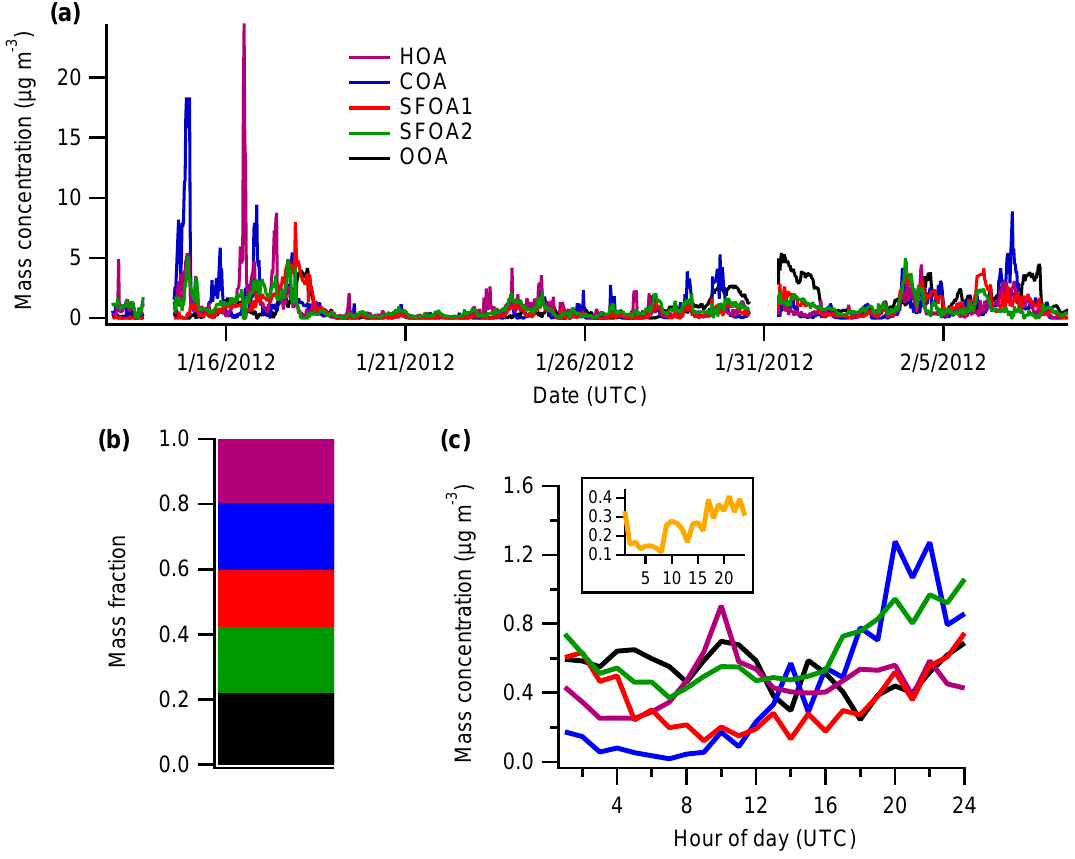
Figure 1. (a) Time series of the 5-factor-PMF solution from the HR-ToF-AMS. (b) Average fractional contribution to the total non-refractory submicron organic aerosol mass, where the residual accounts for 1.24% of the mass (also see Fig. S27 in Sect. 5.1.2 in the Supplement to Young et al. (2014), the complementary paper). (c) Median diurnal profiles for each of the five factors and the diurnal profile of the difference between the two SFOA factors (SFOA2-SFOA1,